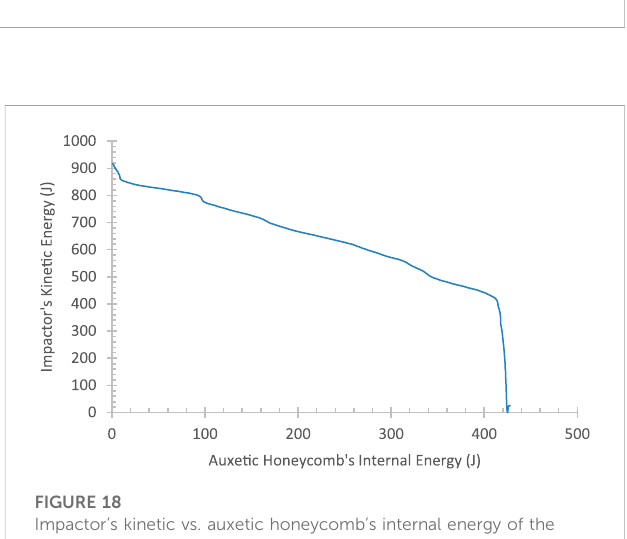
FIGURE 17 CAD of optimum